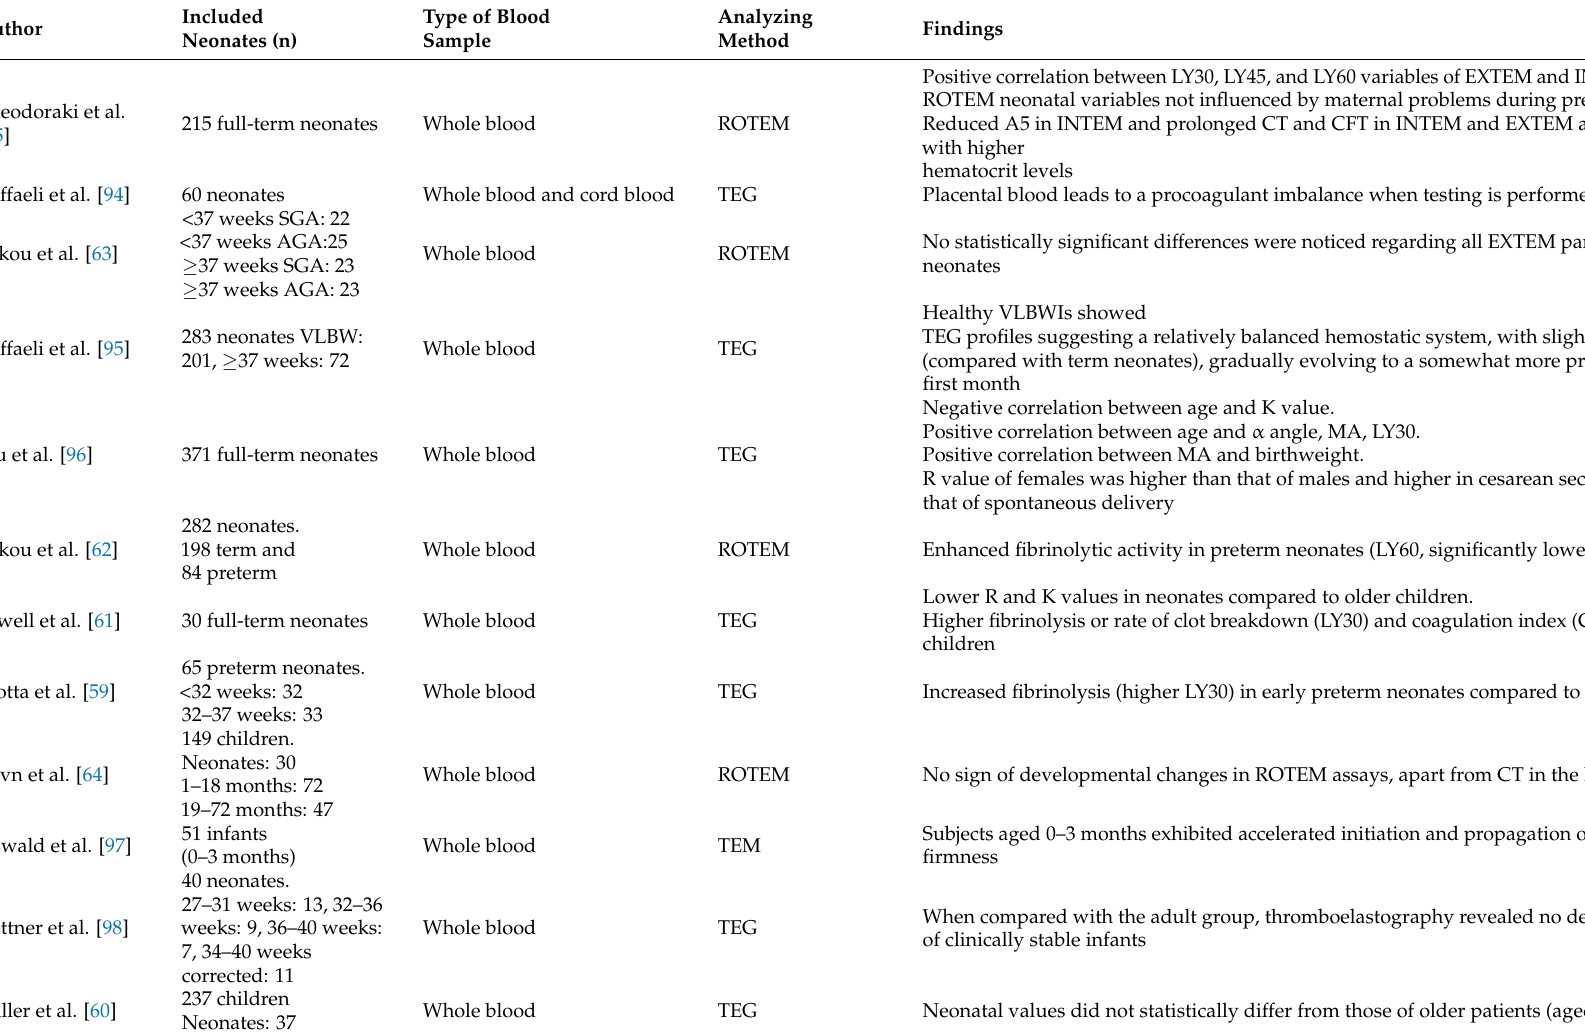
Table 6. Main TEG®/ROTEM®results obtained in the sick neonatal population: study